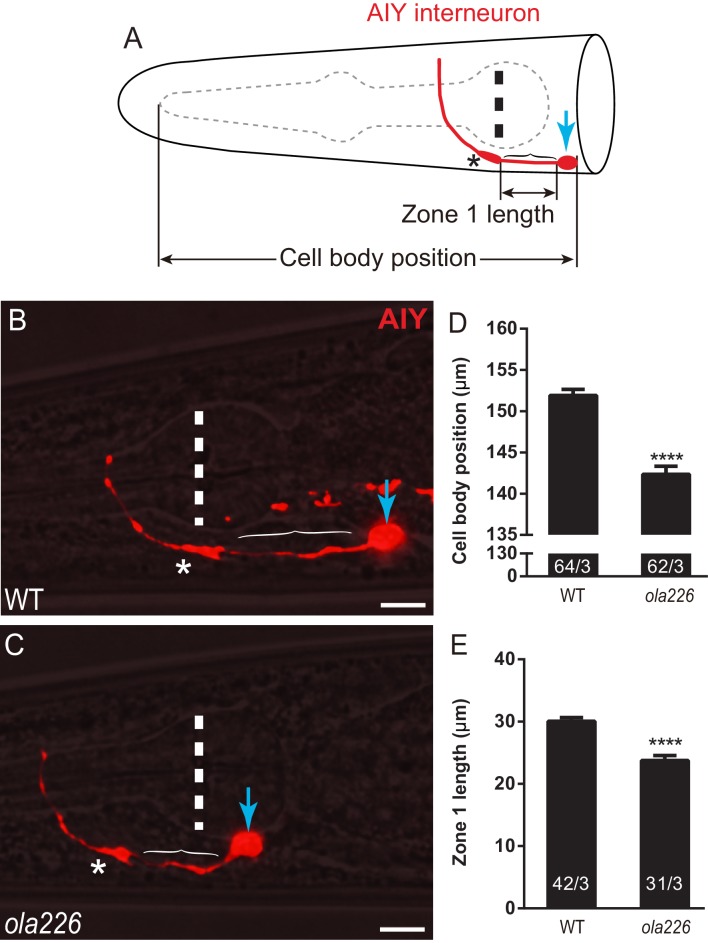
ola226 affects AIY neurite and cell body position.(A) A cartoon diagram of AIY (red) in the C. elegans head. The blue arrow indicates the cell body, bracket indicates the Zone 1 region, asterisk indicates the Zone 2 region, and vertical dashed line indicates center of pharynx bulb here and in micrographs B and C. Lengths scored for cell body position (graph in D) and Zone 1 length (graph in E) are shown. (B–C) Confocal micrographs of AIY (red) with bright field microscopy for wild type (B) and ola226 mutants (C). In (B), a co-marker used in the study is also visible proximal to AIY. Importantly for the study, while AIYs have the same shape in the inspected genotypes, note the differences in the AIY neurite and cell body positions between these two genotypes compared to the pharynx bulb (visible with bright field). (D–E) Quantification of the position of AIY (length between the tip of pharynx and the AIY cell body, as indicated in the schematic in (A)) in (D). Quantification of the length of Zone 1 (E) in wild type and ola226 mutant animals. The AIY position is quantified by measuring the distance between the tip of the pharynx and the center of AIY soma. Although the length of pharynx of mig-17 mutants is increased, the length indicating the AIY position is decreased, suggesting that the change of the AIY position is not a second effect of the pharynx defect. In the graph, the total number of animals (N) and the number of times scored (n) are indicated in each bar for each genotype as N/n. Error bars represent SEM. Statistical analyses are based on two-tailed student’s t-test, ****p<0.0001.